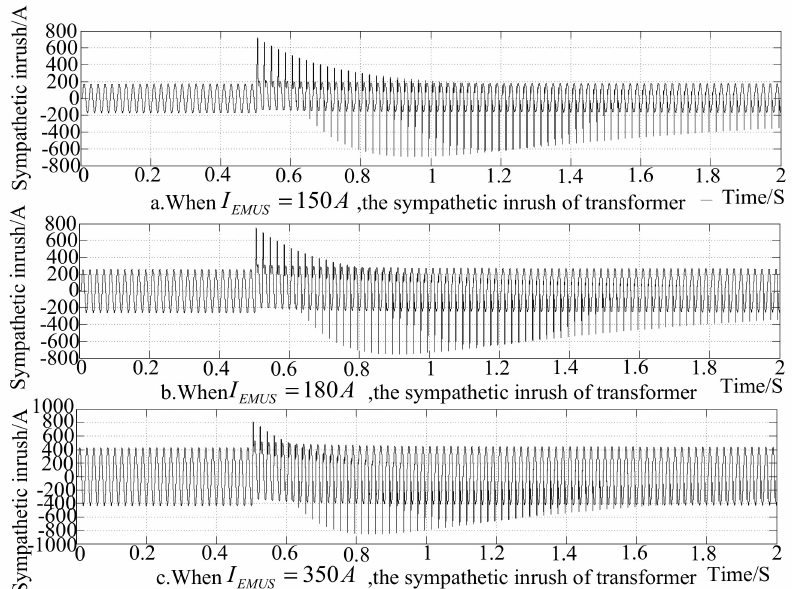
Figure 14. Sympathetic inrush of the traction transformer under di ff erent load